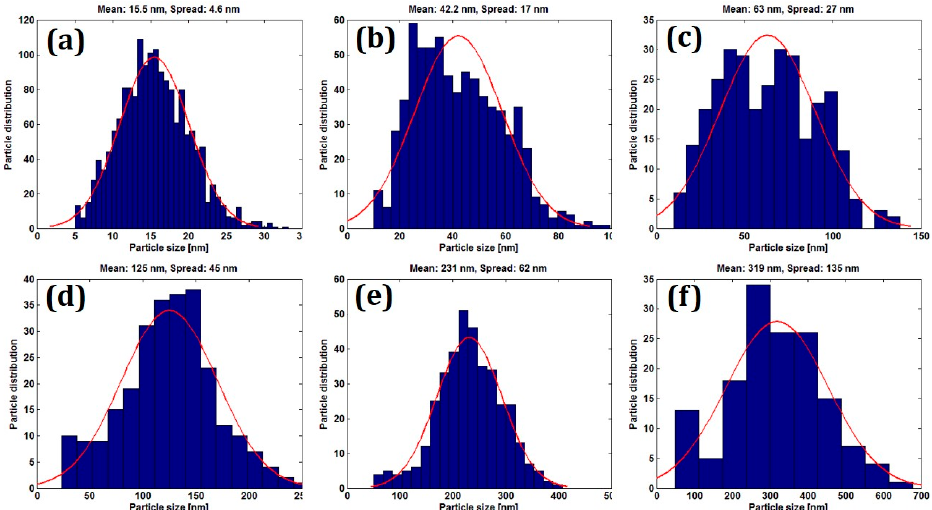
Figure 3. ( a – f ) Size distribution of nanoparticles formed by RTP of samples with deposited Au film thicknesses of 3 nm, 5 nm, 7 nm, 9 nm, 11 nm and 13 nm, respectively.